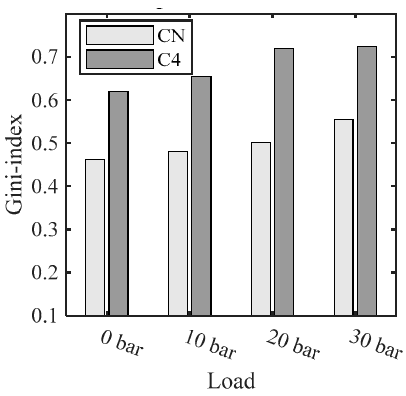
Figure 13. MSB bearing Gini Index for different clearances.